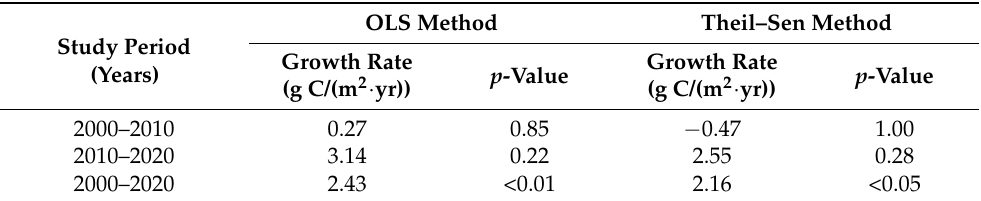
Table 5. Growth trend of grassland NPP in the different periods based on the two-tailed significance test method. OLS Method Theil–Sen Method Study Period Growth Growth Rate (Years) p -Value (g C/(m 2 · yr))